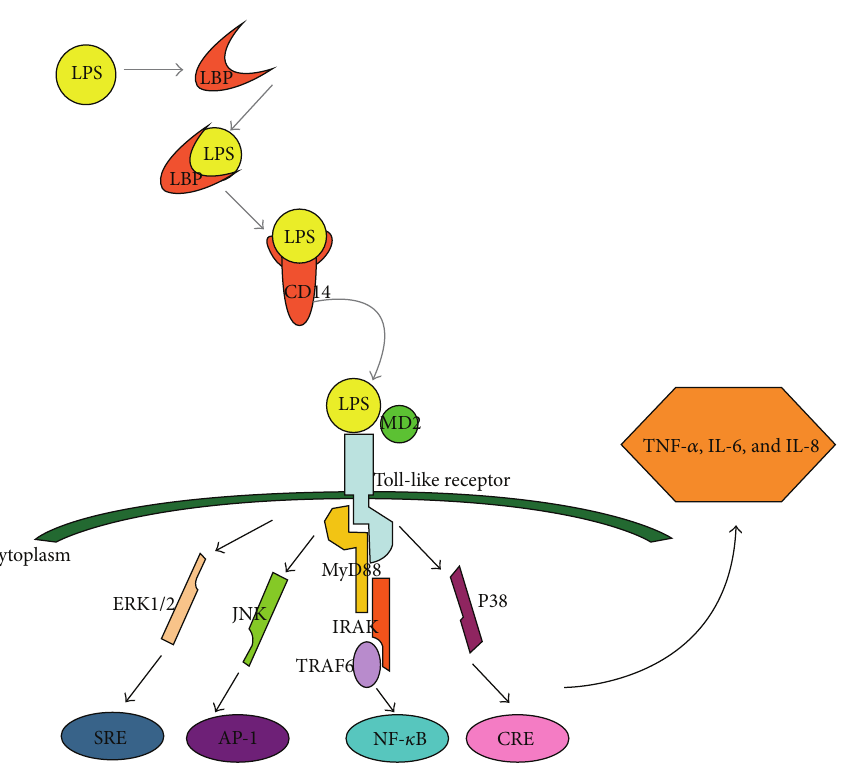
Figure 2: A cartoon outlining the major events in recognition of LPS in the human